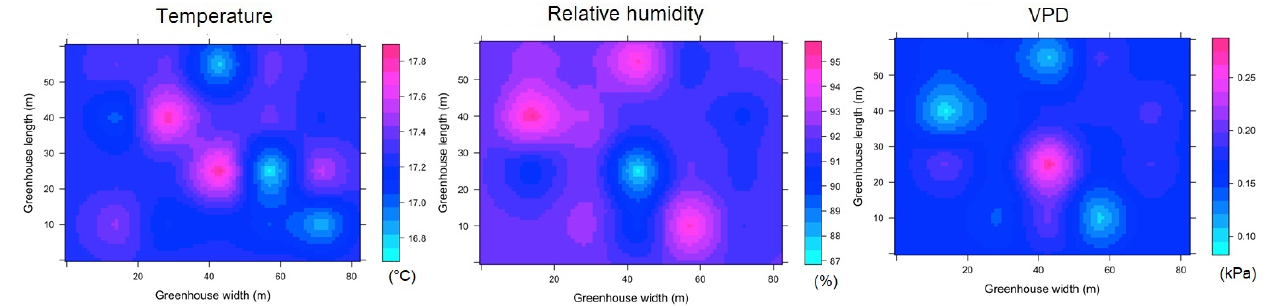
Figure A13. Spatial distribution predicted by kriging, for temperature, relative humidity and VPD in HGT2 and for ESRL 2.